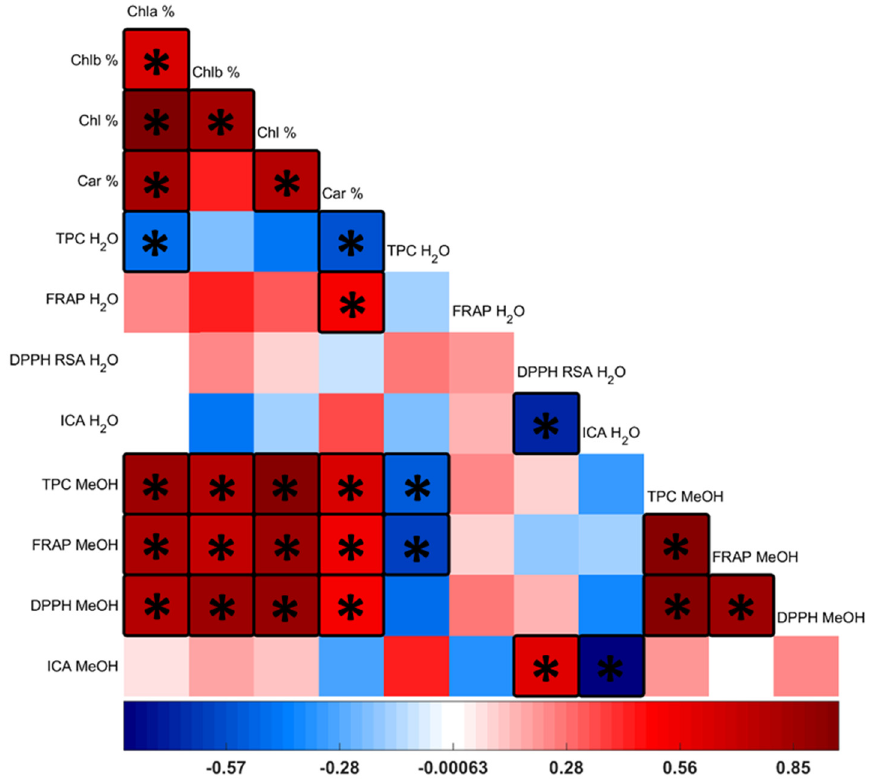
Figure 4. Correlation matrix (Pearson). Color bar at the bottom indicated the Pearson correlation coefficient value. Stars (*) indicate difference from 0 with a significance level alpha = 0.05. Figure created in Matlab with code provided by Layden et al. [63].